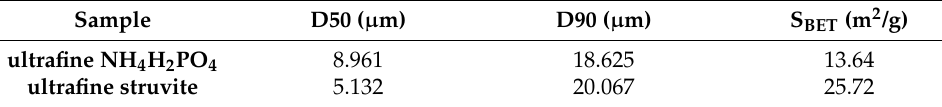
Table 1. Particle size and BET of two samples.